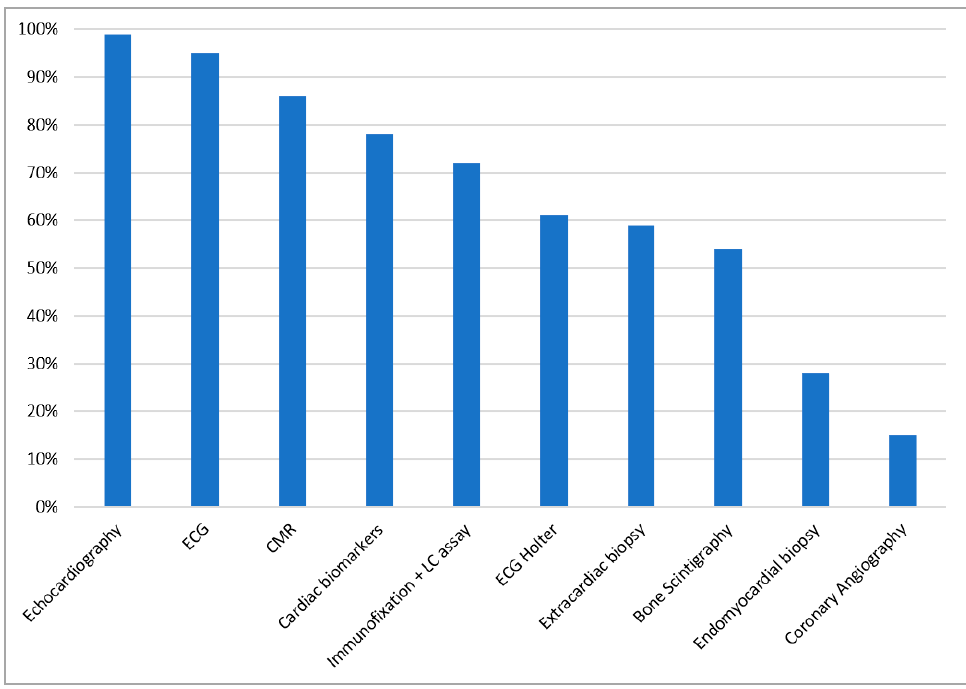
Figure 3. Diagnostic tests considered by the survey participants in patients with heart failure and suspicion of cardiac amyloidosis. CMR cardiac magnetic resonance, ECG electrocardiogram, LC light chain. Cardiac biomarkers are represented by NT-pro BNP and troponin.